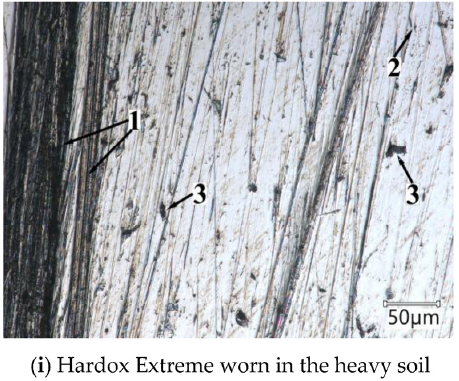
Figure 5. The surfaces of the tested steels worn in the different soil masses: 1—ploughing, 2—microcutting, 3—chippings, 4—plastic deformation. Light optical microscopy.